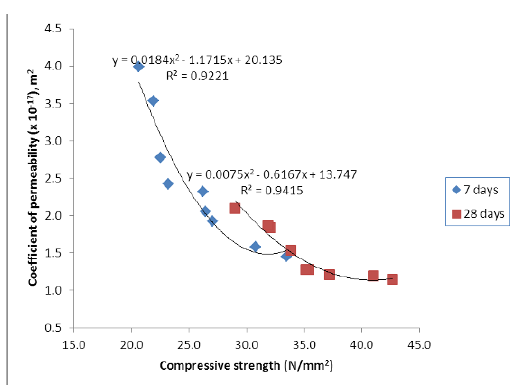
Figure 9. Relationship between compressive strength and coeffi- cient of permeability.